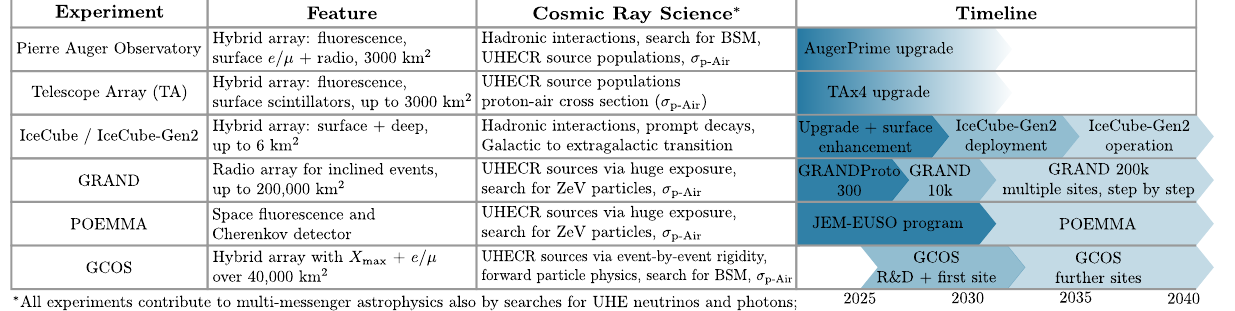
Figure 2. Current and future experiments leading the field of ultra-high-energy cosmic rays. To some extent, all experiments contribute to both astrophysics and particle physics related to UHECR. Nonetheless, they have di ff erent strengths and complement each other: the Pierre Auger Observatory currently provides the highest measurement accuracy and largest exposure for UHECR and is in the southern hemisphere; the upgraded Telescope Array will provide a similar exposure at the highest energies in the northern hemisphere; IceCube(- Gen2) with its surface and in-ice arrays is a unique laboratory to measure air showers up to a few EeV, i.e., up to the energy range of the Galactic-to-extragalactic transition; GRAND and POEMMA will o ff er the highest statistics for UHECR with very complementary approaches and will additionally target UHE neutrinos; GCOS will be optimized for high statistics and high accuracy at the same time to provide an event-by-event rigidity measurement of UHECR. (Figure from Ref.